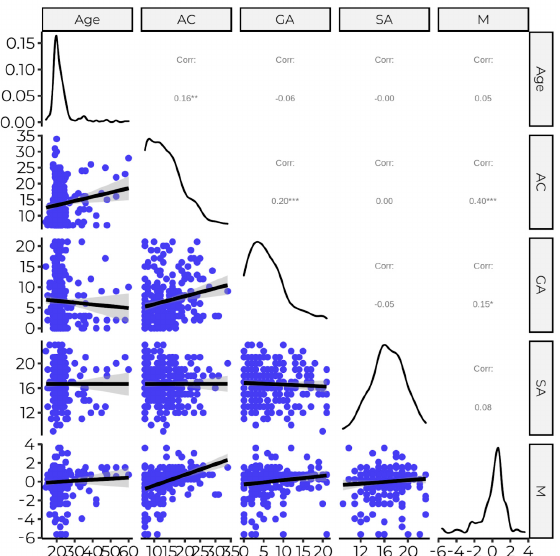
Figure 4. Corrplot for continuous variables. Above the main diagonal of the matrix, the correlation coefficient values and their significance was presented; at the main diagonal one dimensional den- sity estimation of subsequent variables, and under the main diagonal two-dimensional